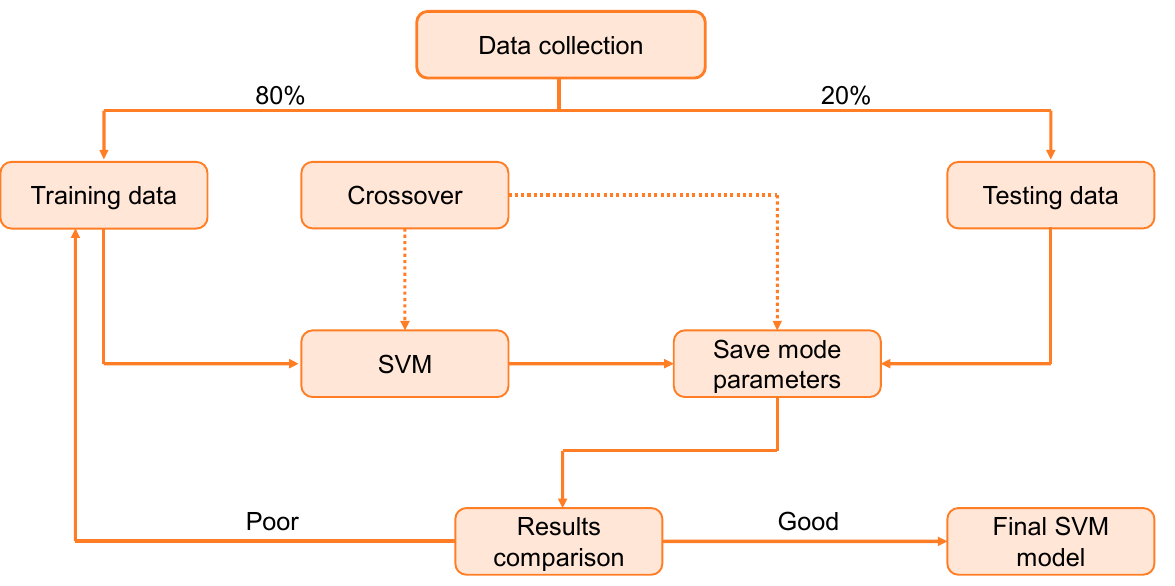
Figure 4. Sequence of support vector machine modeling process.